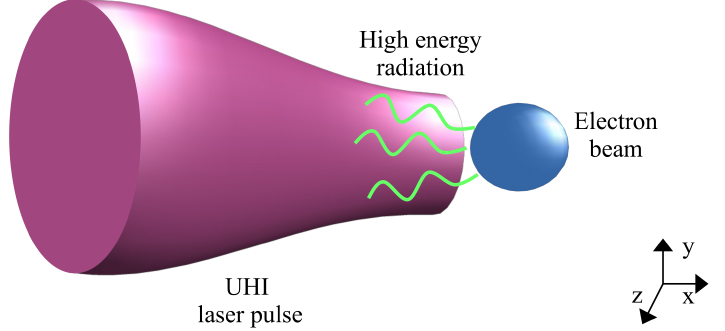
Figure 1. An ultra high intensity laser pulse colliding with an energetic electron beam. The laser parameters are: wavelength λ = 1 µ m, peak intensity I : { 10 19 –10 23 } W/cm 2 , pulse duration τ = 30 fs FWHM and focal spot size w 0 = 3 µ m. For the 2D simulation setup, the electron beam parameters are: n e 0 = 10 − 5 n c , L x = 0.8 µ m, L y = 0.16 µ m and ε